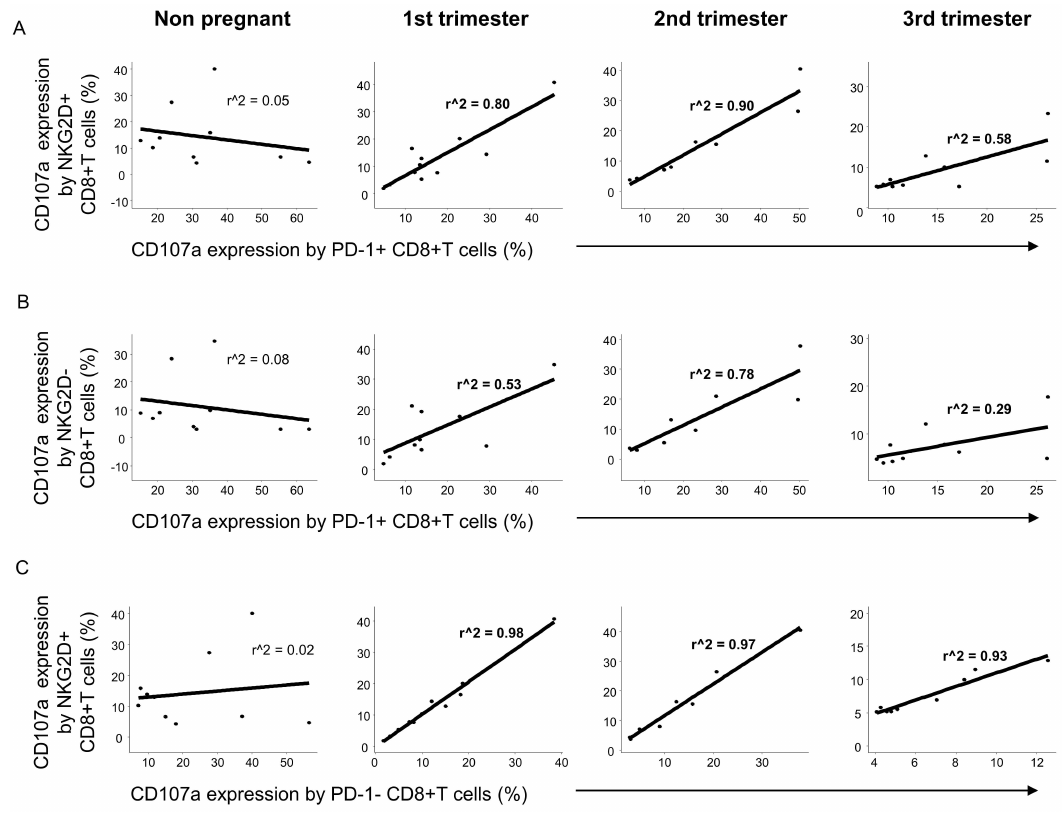
Figure 7. The regression of the CD107a expression by PD-1 and NKG2D positive / negative subpopulations in CD8 + T cells throughout pregnancy and in nonpregnant women. Linear regression analyses between the CD107a expression by the PD-1 +/ NKG2D + ( A ), PD-1 +/ NKG2D − ( B ) and PD-1 − / NKG2D + ( C ) subpopulations in CD8 + T cells in women during healthy pregnancy and in nonpregnant women. p values and coe ffi cients of determination (R2) were calculated in R. Similarly to CD8 + T cells, a positive relationship was observed between the cytotoxic activity of the PD-1 positive and NKG2D positive NKT-like cell populations throughout pregnancy but not in the nonpregnant control group (Figure 8A). Examining the connection of the CD107a expression by PD-1 positive and NKG2D negative NKT-like cells, a weak positive relationship was observed only in the 2nd and 3rd trimester of pregnancy (Figure 8B). Moreover, strong positive linear regression was defined between the cytotoxicity in PD-1 negative and NKG2D positive NKT-like cells during the healthy pregnancy but not nonpregnant condition (Figure